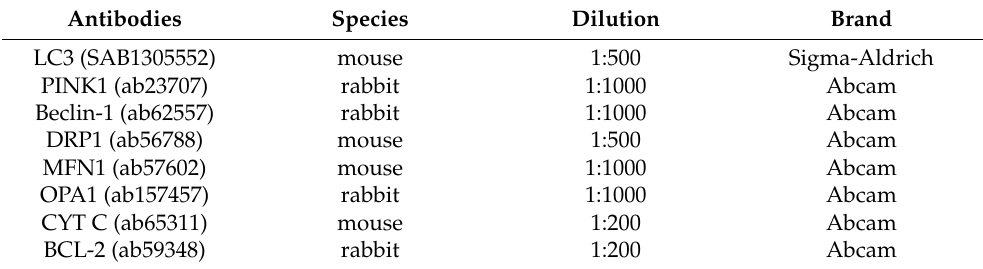
Table 1. Antibodies used in the WB analysis. We reported the host species, the dilution, and the brand of each antibody. Antibodies Species Dilution Brand LC3 (SAB1305552) mouse 1:500 Sigma-Aldrich PINK1 (ab23707) rabbit 1:1000 Abcam Beclin-1 (ab62557) rabbit 1:1000